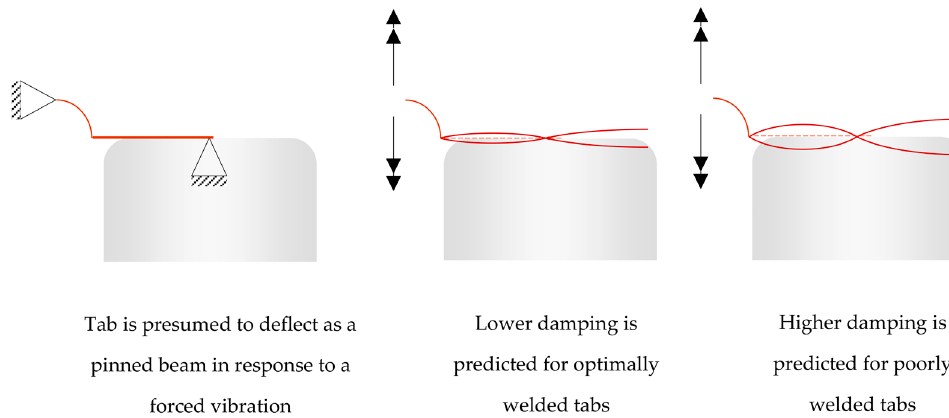
Figure 2. Resonance modes of battery tabs are predicted to be dependent on weld quality.